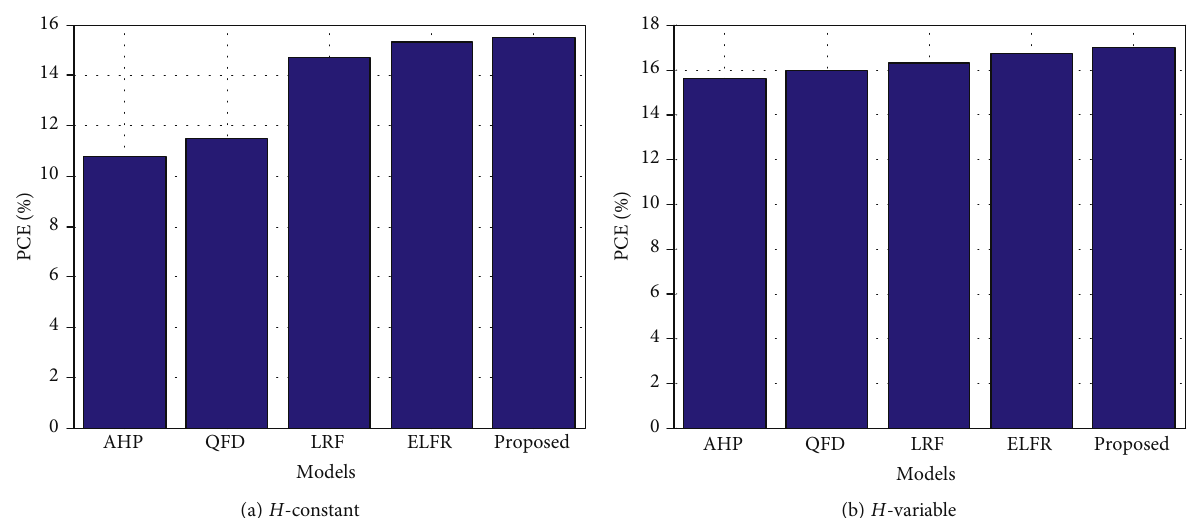
Figure 5: Power conversion e ffi